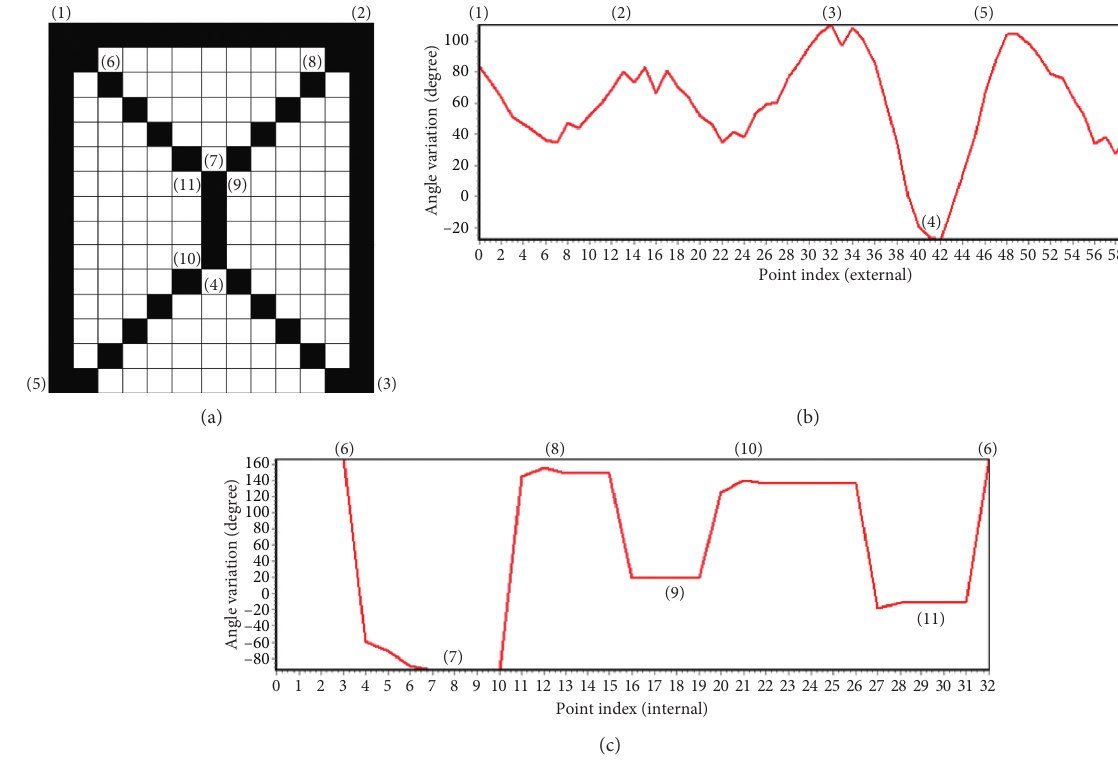
Figure 9: KPs definition and angle variation of pattern element 0 when r � 3. (a) KPs definition of the element with label 0. (b) Angle variation of external point of chain sequence for the pattern element. (c) Angle variation of internal point of chain sequence for the pattern element.